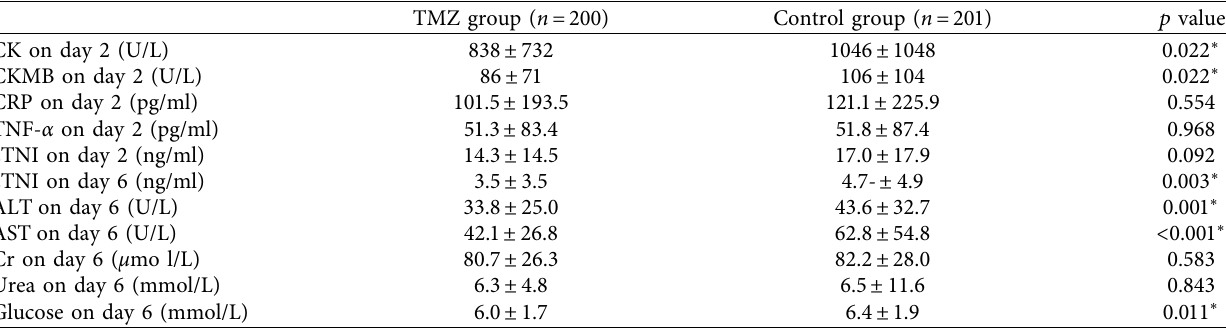
Table 4: Repeated laboratory data collected in the hospital.